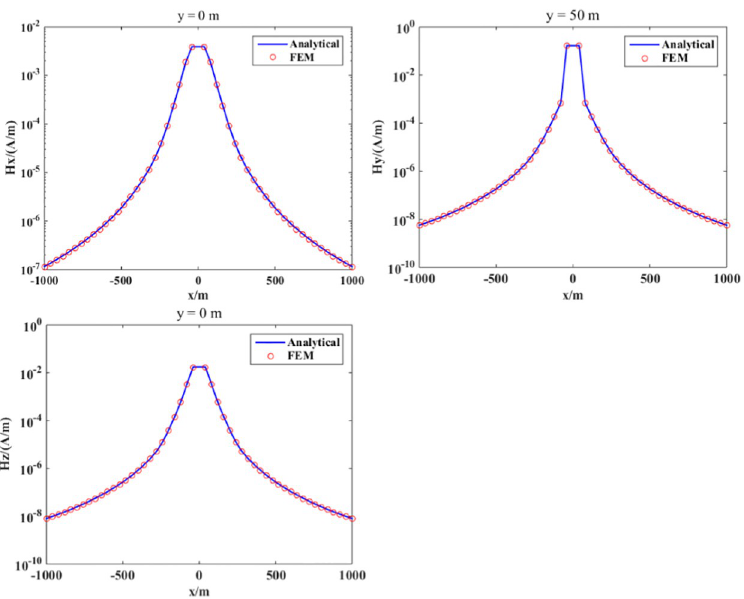
Fig 10. Comparison of the FEM results with the semi-analytical solution. From top to bottom are the Hx, Hy and Hz magnetic-field components.